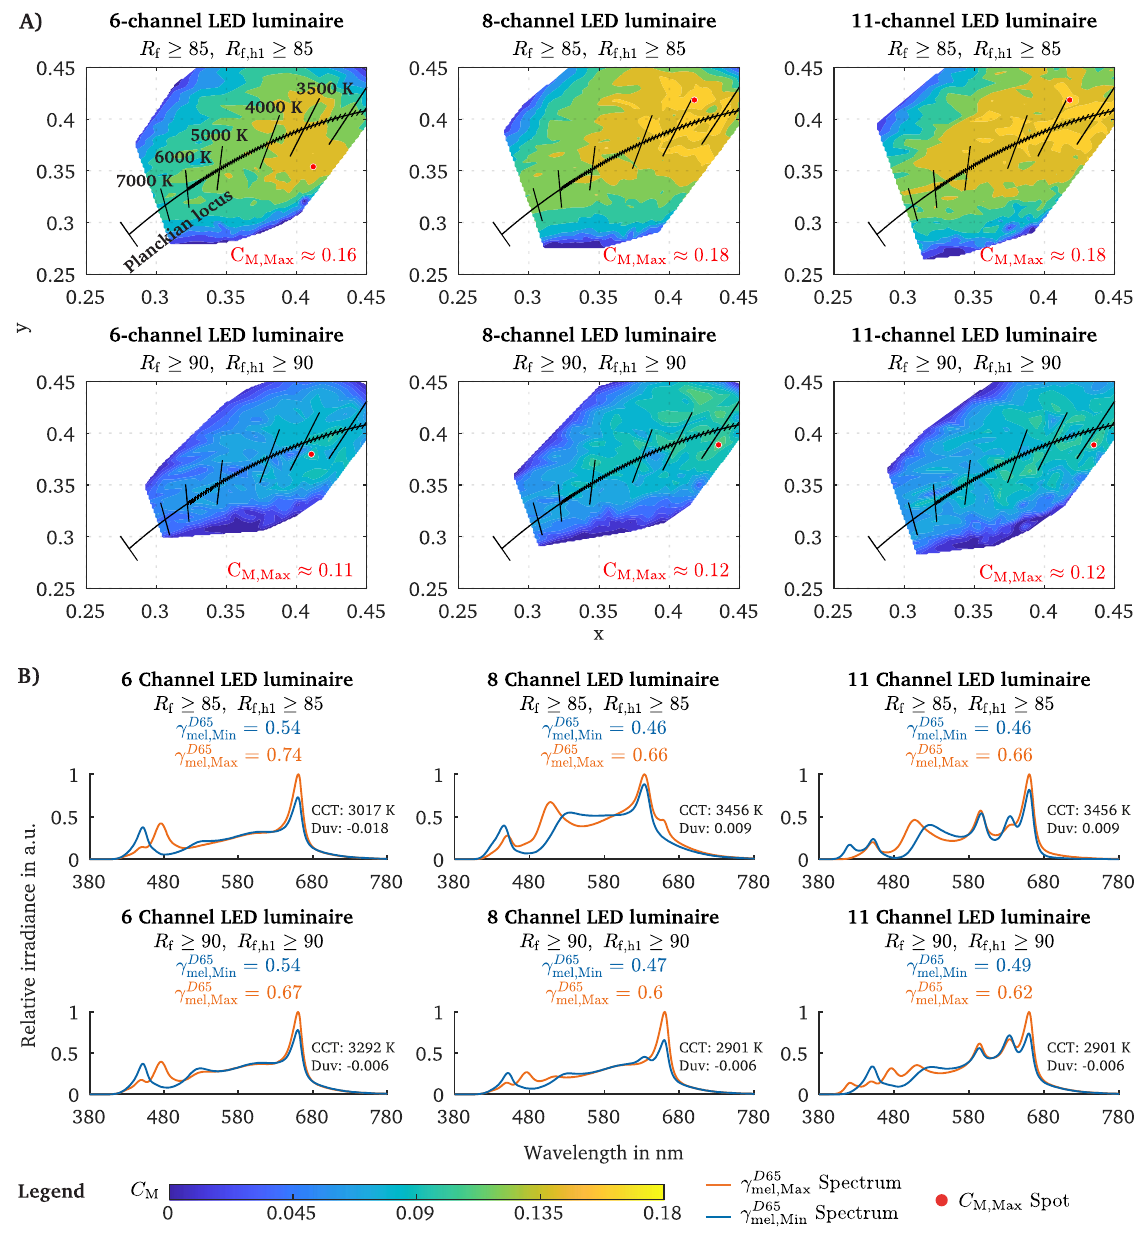
Figure 3. Melanopic metameric tuning limits (expressed in terms of melanopic Michelson contrast as derived D 65 E D 65 from the maximum and minimum melanopic EDI, E mel , Max and mel , Min ) at fixed photopic illuminance (250 lx). ( A ) The distribution of the melanopic Michelson contrast C M in the CIExy-2° colour space for three D 65 E D 65 LED luminaire settings and two IES colour fidelity index R f conditions by using the E mel , Max and mel , Min value of each chromaticity coordinate at a fixed photopic illuminance of 250 lx. The red dots signal the CIExy coordinates at which the melanopic Michelson contrast is maximal across all CCT and Duv steps ( C M , Max ). The value of C M , Max is reported in the lower left of each metameric map plot. ( B ) The maximum melanopic D 65 E D 65 Michelson contrast C M , Max (red dot, panel A ) is derived by using the E mel , Max and mel , Min values of the spectral pair that corresponds to the red dot. The two spectra of the metameric pair, which maximise the melanopic Michelson contrast ( C M , Max ), are plotted for each luminaire setting and colour fidelity the metameric Michelson contrast. The applied tolerance of (cid:31) u ′ , (cid:31) v ′ ≤ 0.001 was chosen so that the ellipses (Fig. 1B, step 2) around each chromaticity coordinate did not overlap, as we used a tight grid of optimisation targets along the Planckian locus (Fig. 1A). The projection of the metamerism contrast values C M into the CIExy colour space (Fig. 3A) shows distinct areas in which a certain level of melanopic modulation can be achieved. For example, using the 6-channel lumi- naire, metameric spectra (R f ≥ 85, R f,h1 ≥ 85) with a C M of at least 0.14 can be generated when choosing CCTs